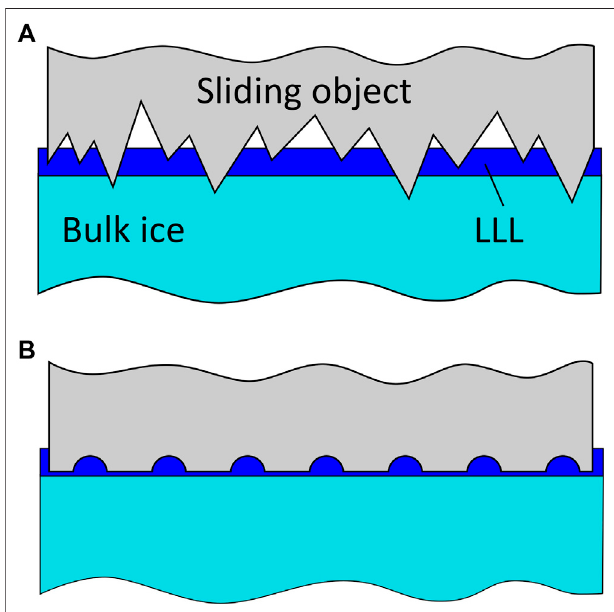
FIGURE 1 | Schematic representation of an interaction between a sliding objectand ice: (A) objecthassharp asperities; (B) objecthassmalldimples.For bothcases,thecommonsurfaceroughnessparameterssuchasSaorRamight have the same value, but on ice these surfaces will perform very